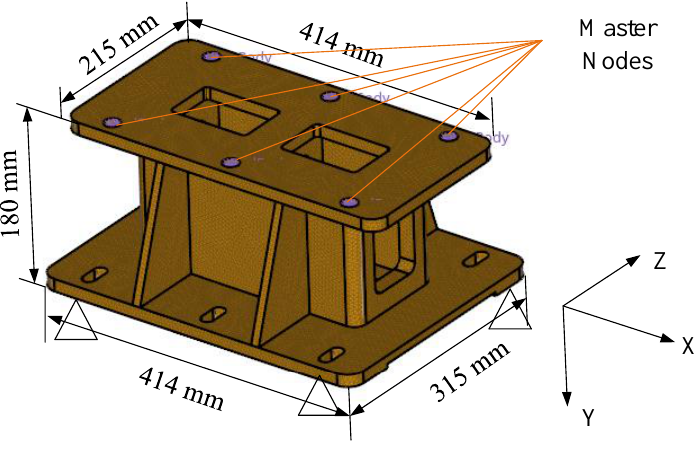
Figure 4. Revised Figure 4. The foundation FE